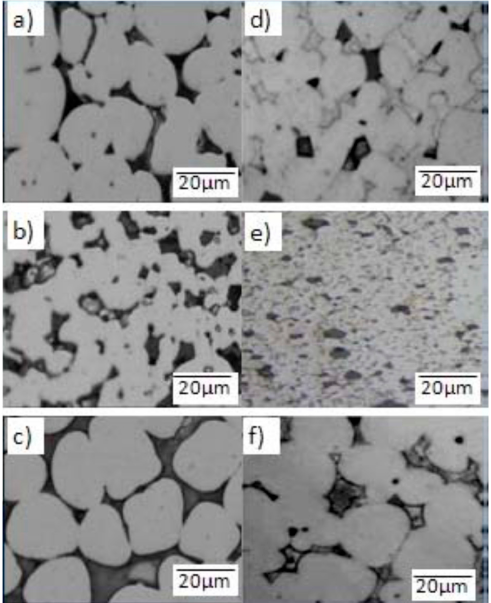
Figure 19. Optical image of WHA’s ( a ) MA (95W–1.5Fe–3.5Ni), ( b ) MA (93W–1Fe–4.5Ni–1.5Co), ( c ) MA (90W–4Cu–6Ni), ( d ) chemical method (95W–1.5Fe–3.5Ni), ( e ) chemical method (93W–4.5Ni–